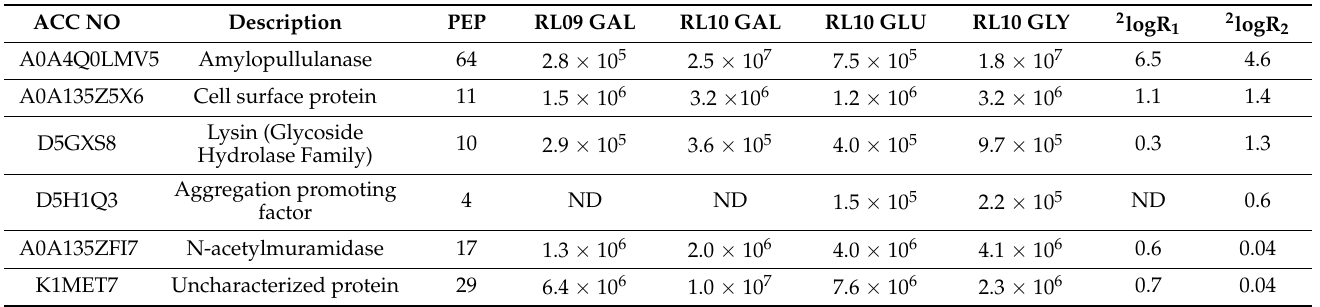
Table 1. Levels of SLAP domain containing proteins in the S-layer enriched fraction of L. crispatus . Columns in the table include ACC NO, UniProt Accession Number; PEP, number of detected